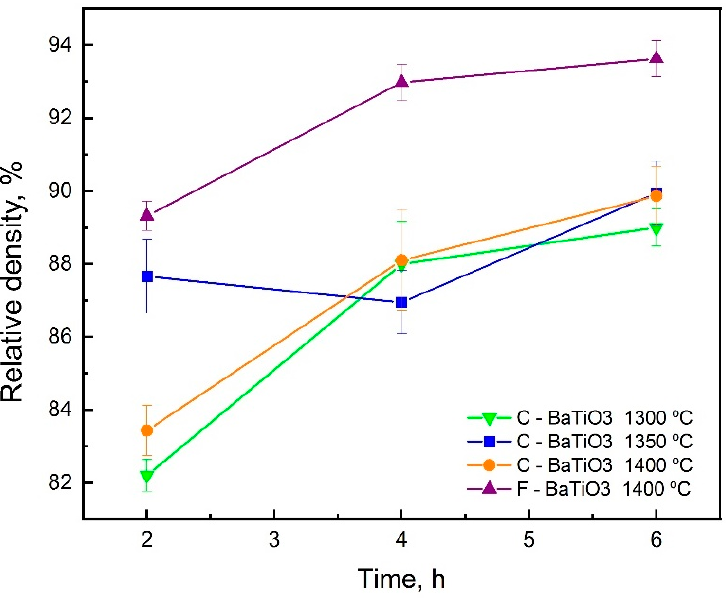
Figure 8. Dependence of the density of samples on temperature and dwell time of sintering. Increasing the temperature and dwell time of sintering leads to grain enlargement.